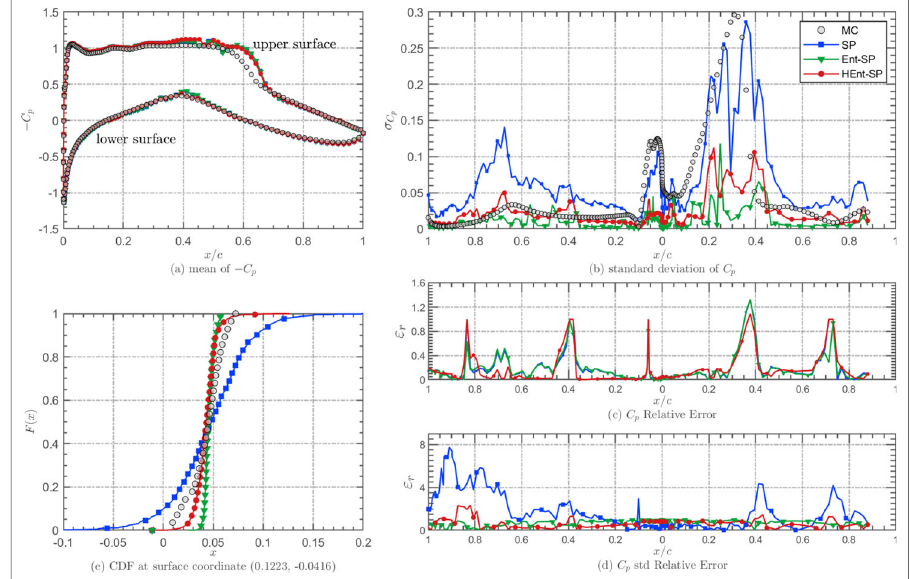
Fig. 16 Performance comparison of SP, Ent-SP and HEnt-SP w.r.t. the RAE2822